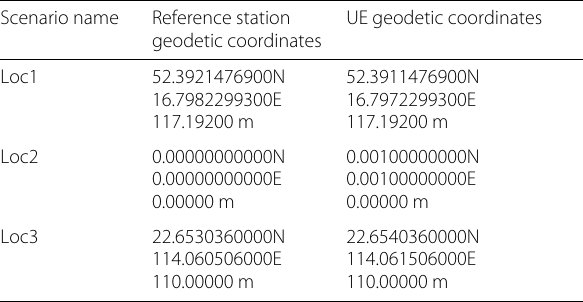
Table 1 Coordinates of the reference station and UE used in the